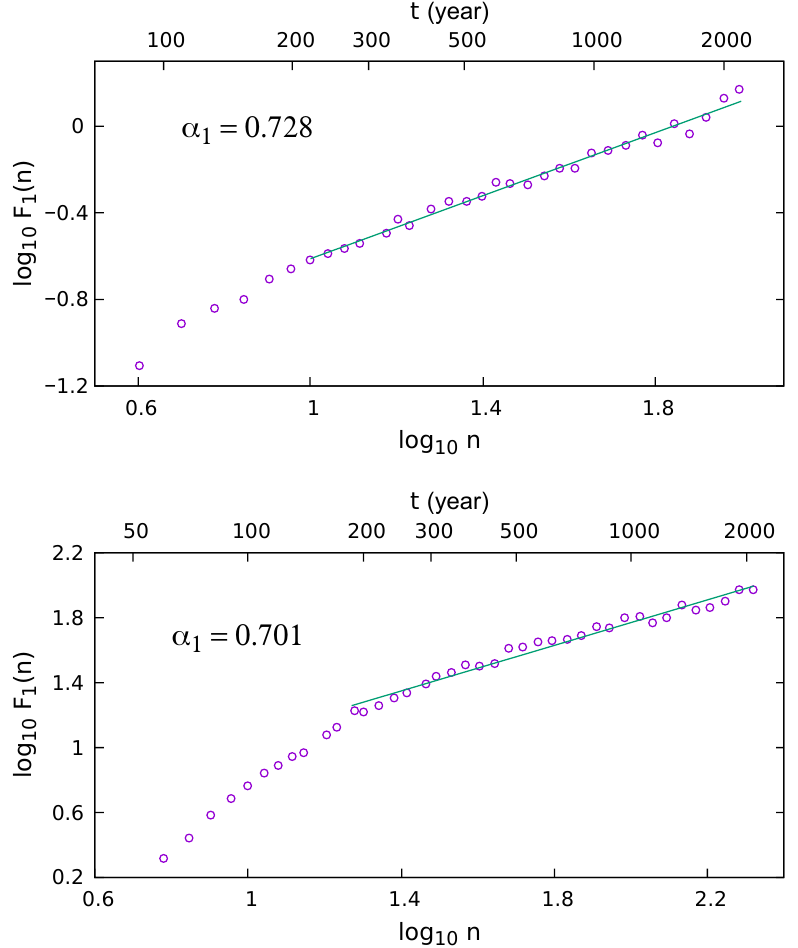
Figure 2. ( Top panel ) log F 1 ( n ) (circles) versus log n calculated through the DFA(1) method applied to the sunspot number reconstruction (SNR04), reprinted from Solanki et al. [30]. The green solid line represents a linear least squares fit with slope α 1 = 0.767. ( Middle panel ) log F 1 ( n ) (circles) versus log n calculated through from the DFA(1) method applied to the total solar irradiance reconstruction (TSIR12), reprinted from Steinhilber et al. [31]. The green solid line represents a linear least squares fit with slope α 1 = 0.728. ( Bottom panel ) log F 1 ( n ) (circles) versus log n calculated through the DFA(1) method applied to the sunspot number reconstruction (SNR18), reprinted from Wu et al. [32]. The green solid line represents a linear least squares fit with slope α 1 = 0.701. In all the plots, the timescale t in years is reported on the upper x -axis for